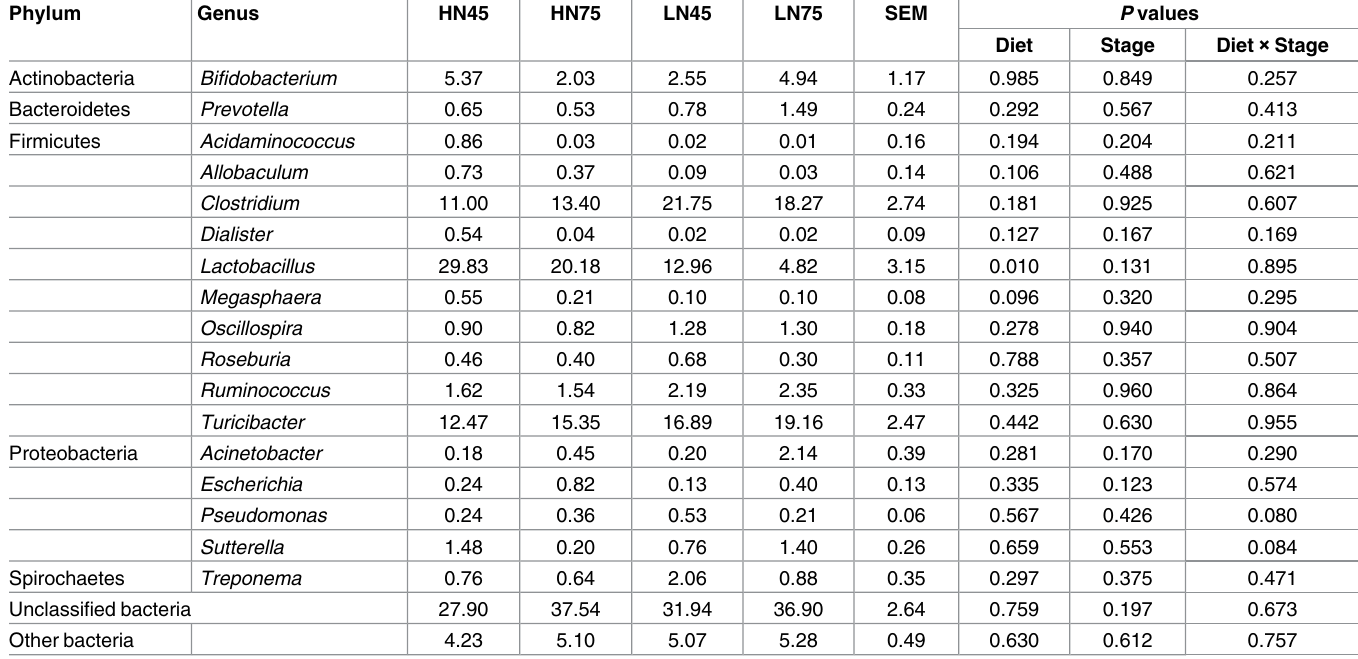
Table 4. Composition of ileal bacterial communities at the genus level in Huanjiang mini-pigs at different stages of pregnancy (%).